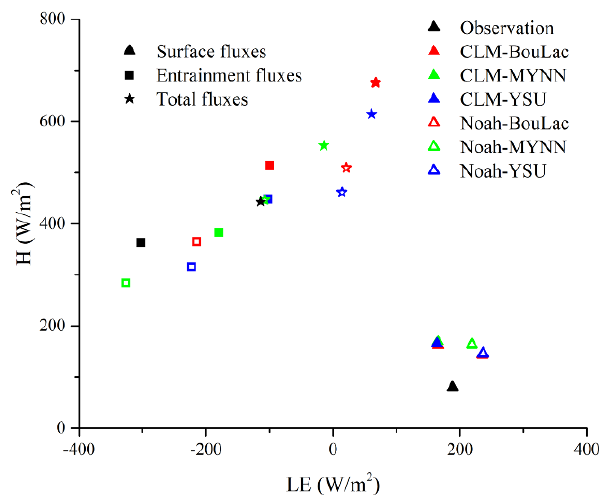
Figure 6. PBL energy balance at BJ/Nagqu. Simulated using CLM and Noah with different PBL